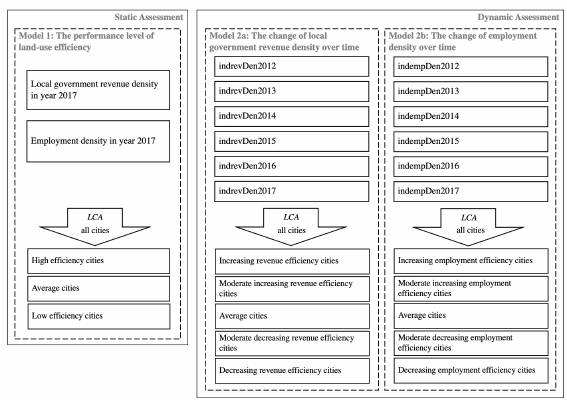
Figure 2. Overall analytical